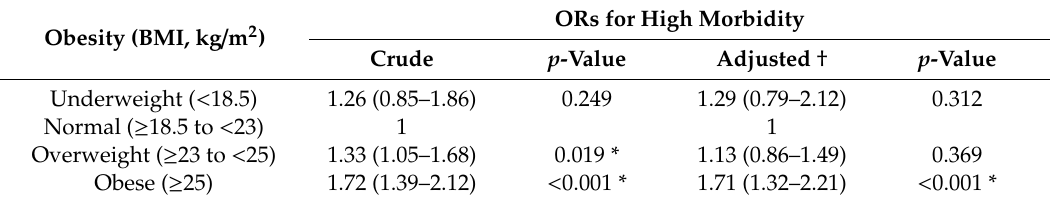
Table 3. Crude and adjusted odd ratios (95% confidence interval) of obesity for maximum morbidity score during hospitalization.